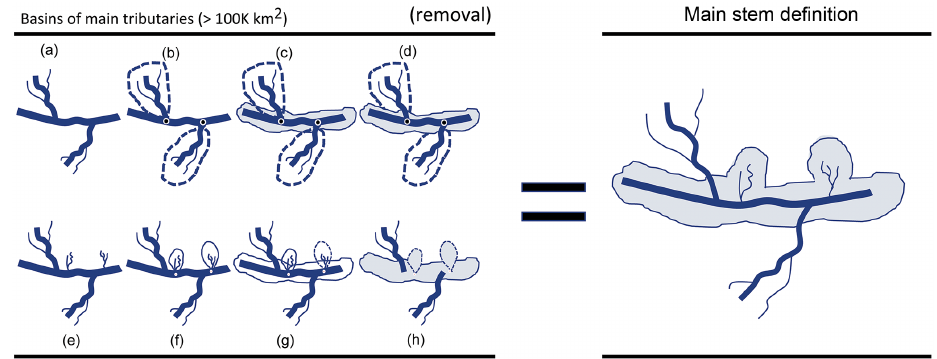
Figure 3. Schematic definition of main stem sub-basins.